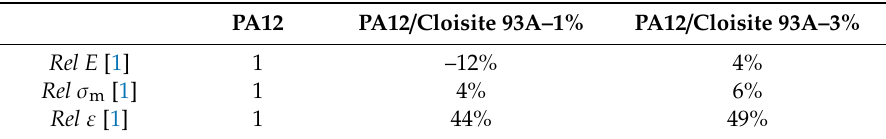
Table 7. Comparison of relative average values of mechanical properties between PA12 and